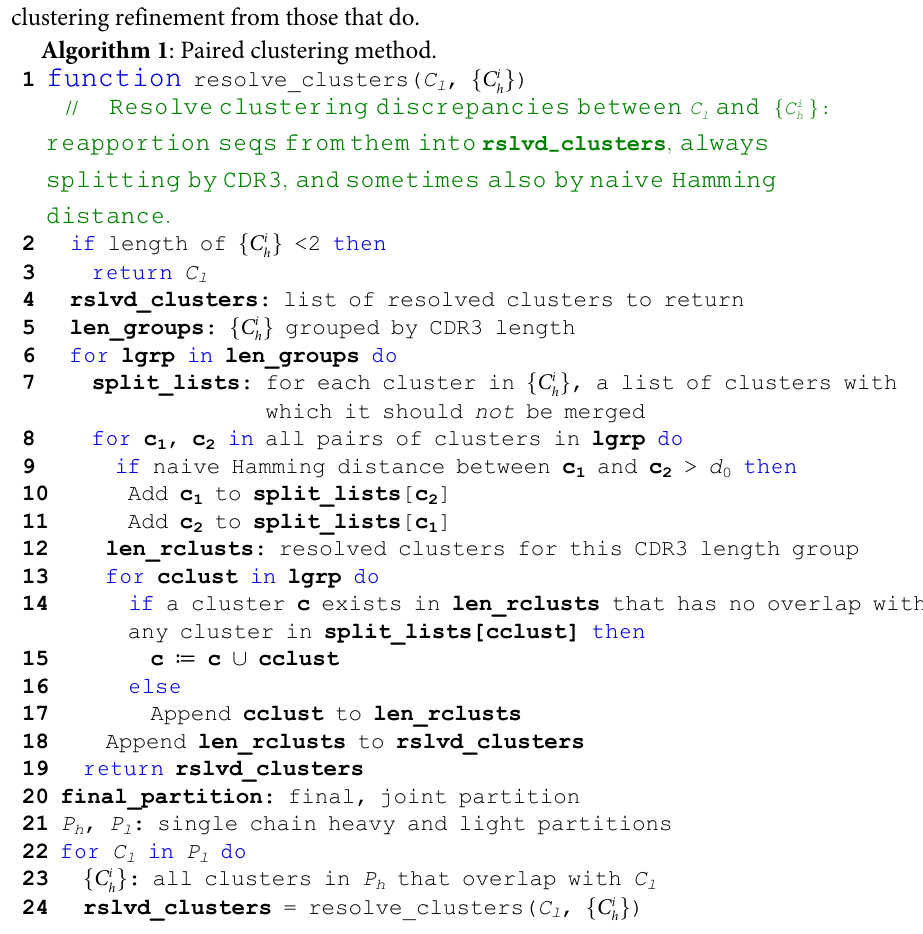
Algorithm 1 : Paired clustering